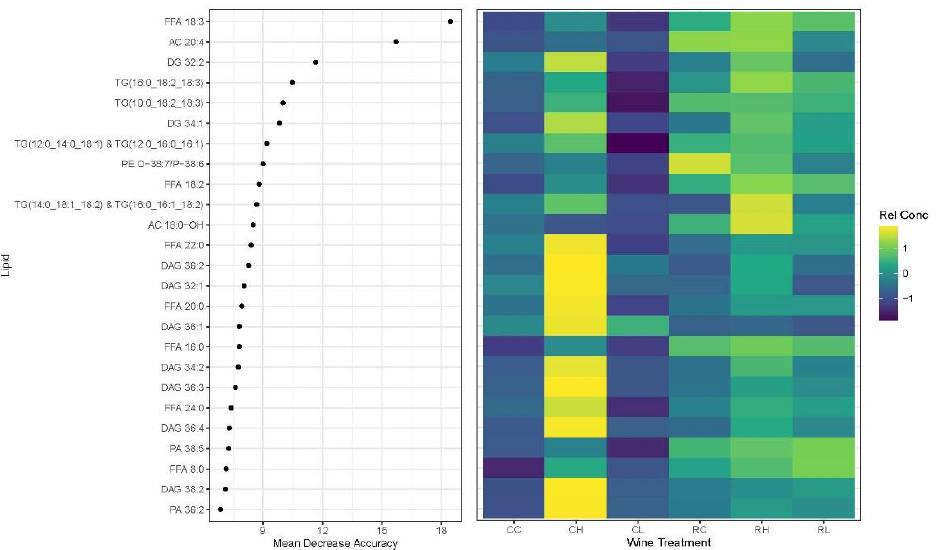
Figure 5. Variance of importance plot (VIP) for lipids that contribute the greatest variance to the classification of six wine treatments. Relative concentrations (Rel Conc) for each group are also shown (yellow for higher concentrations, dark green for lower).